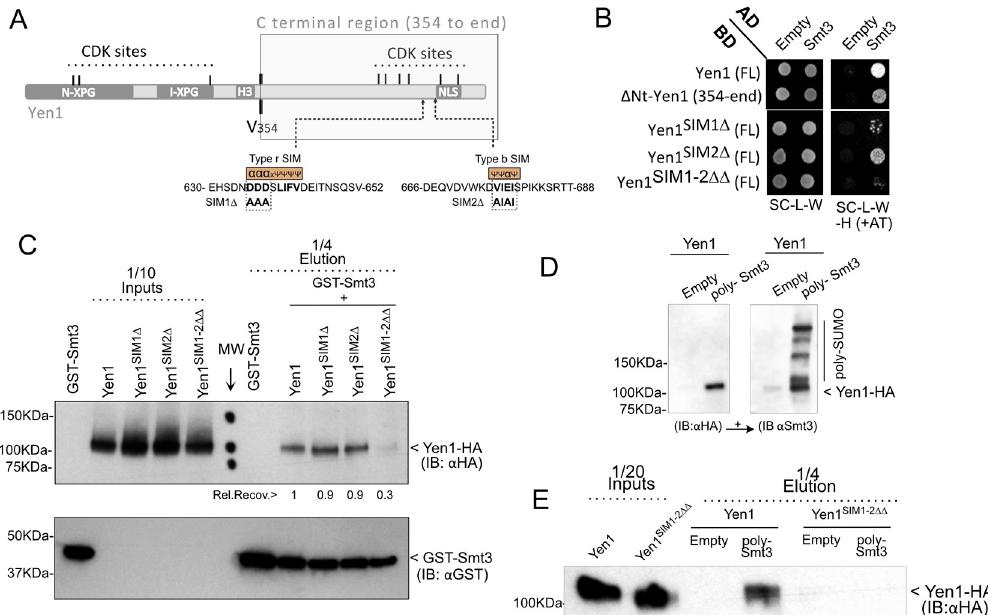
Fig 1. Yen1 contains two SUMO Interacting Motifs (SIMs) in its C-terminal domain. (A) Diagram showing the conserved domains of Yen1 and the positions of the regulatory Cdk1-phosphorylation sites. Amino acid 354 shows the cut-off point for truncated forms of Yen1 in Two-Hybrid assays. The two identified candidate SIMs are shown near the Nuclear localization sequence (NLS). (B) A Yeast two-hybrid assay was performed with strains carrying the indicated Activator Domain (AD) and DNA Binding Domain (BD) fusions to test interaction between Yen1 and Smt3 (SUMO), and the Yen1 critical domains for such interaction. Mutations D635A D636A D637A for SIM1 Δ and V675A E677A for SIM2 Δ were introduced to test for the putative SIMs. SIM1-2 ΔΔ is used for the combined mutations. Strains were grown on selective media lacking leucine and tryptophan and spotted in selective media also lacking histidine to reveal interaction of the proteins fused to the AD and BD domains. Non-specific interactions were minimized by the addition of 3-aminotriazole (AT). (C) Purified GST-Smt3 was bound to a Glutathione resin, and either purified wild-type or the SIM mutant Yen1 proteins were then loaded to the resin. The retained fractions of Yen1 were eluted after several washes and detected by immuno-blotting. (D) SUMO-retention assay using in vitro generated poly-Smt3 immobilized into a Cobalt HisPur Superflow agarose matrix. Purified Yen1 was added to the pre-bound Smt3 and after a binding-time and washing, columns were eluted in denaturing conditions and the eluates inspected by western blot for the presence of Yen1 (anti-HA, left panel) and the pre-bound Smt3 chains (right panel). (E) Immuno-blotting of the inputs and eluates of the retention assay (as in D) comparing the ability of wild-type or SIM-mutant Yen1 to bind poly-Smt3.